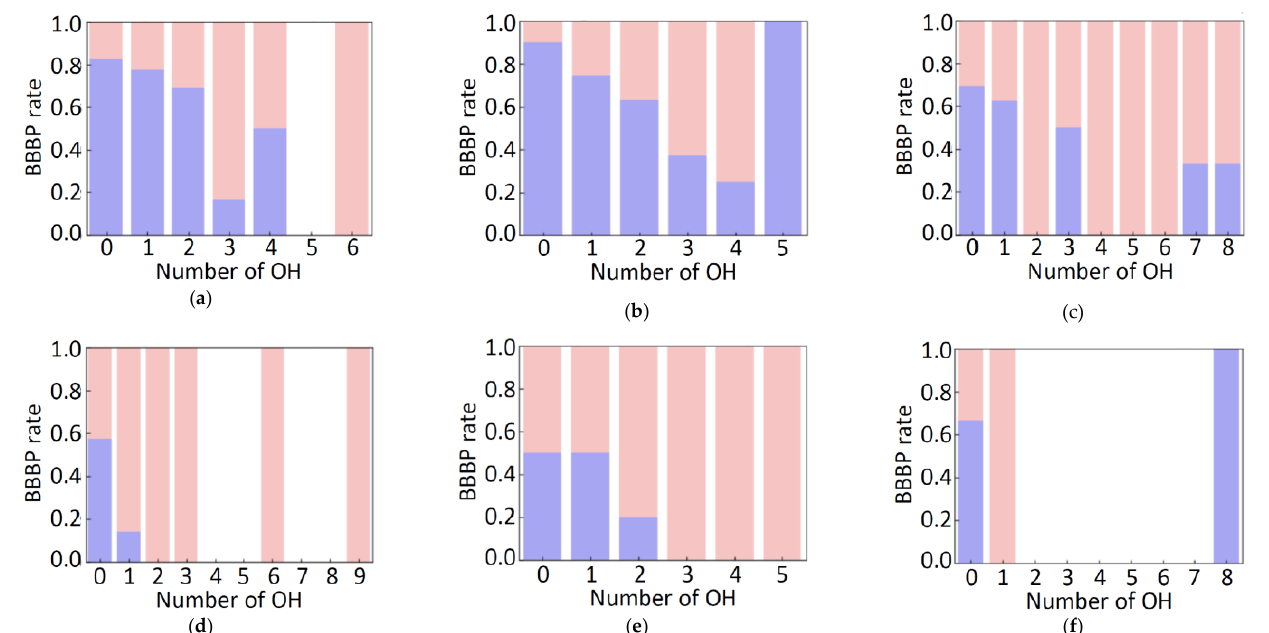
Figure 6. BBBP ratio with respect to the number of aliphatic heterocycles ( n ) and the number of aliphatic hydroxy groups excluding tertiary alcohol OH, showing BBBP positive (blue) and negative (pink) for n = 0 ( a ), 1 ( b ), 2 ( c ), 3 ( d ), 4 ( e ), and 5 ( f ).